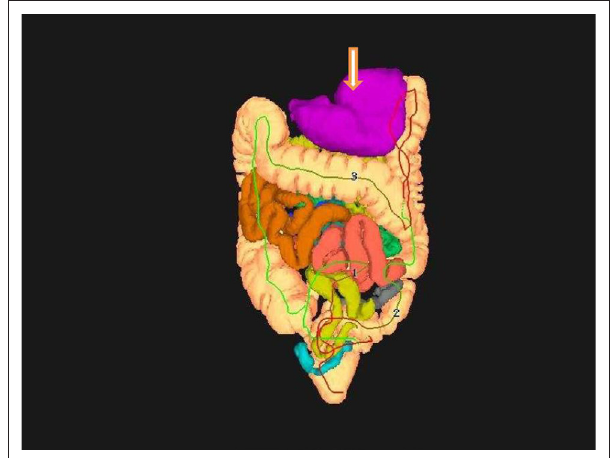
FIGURE 6: Air in stomach (arrow).